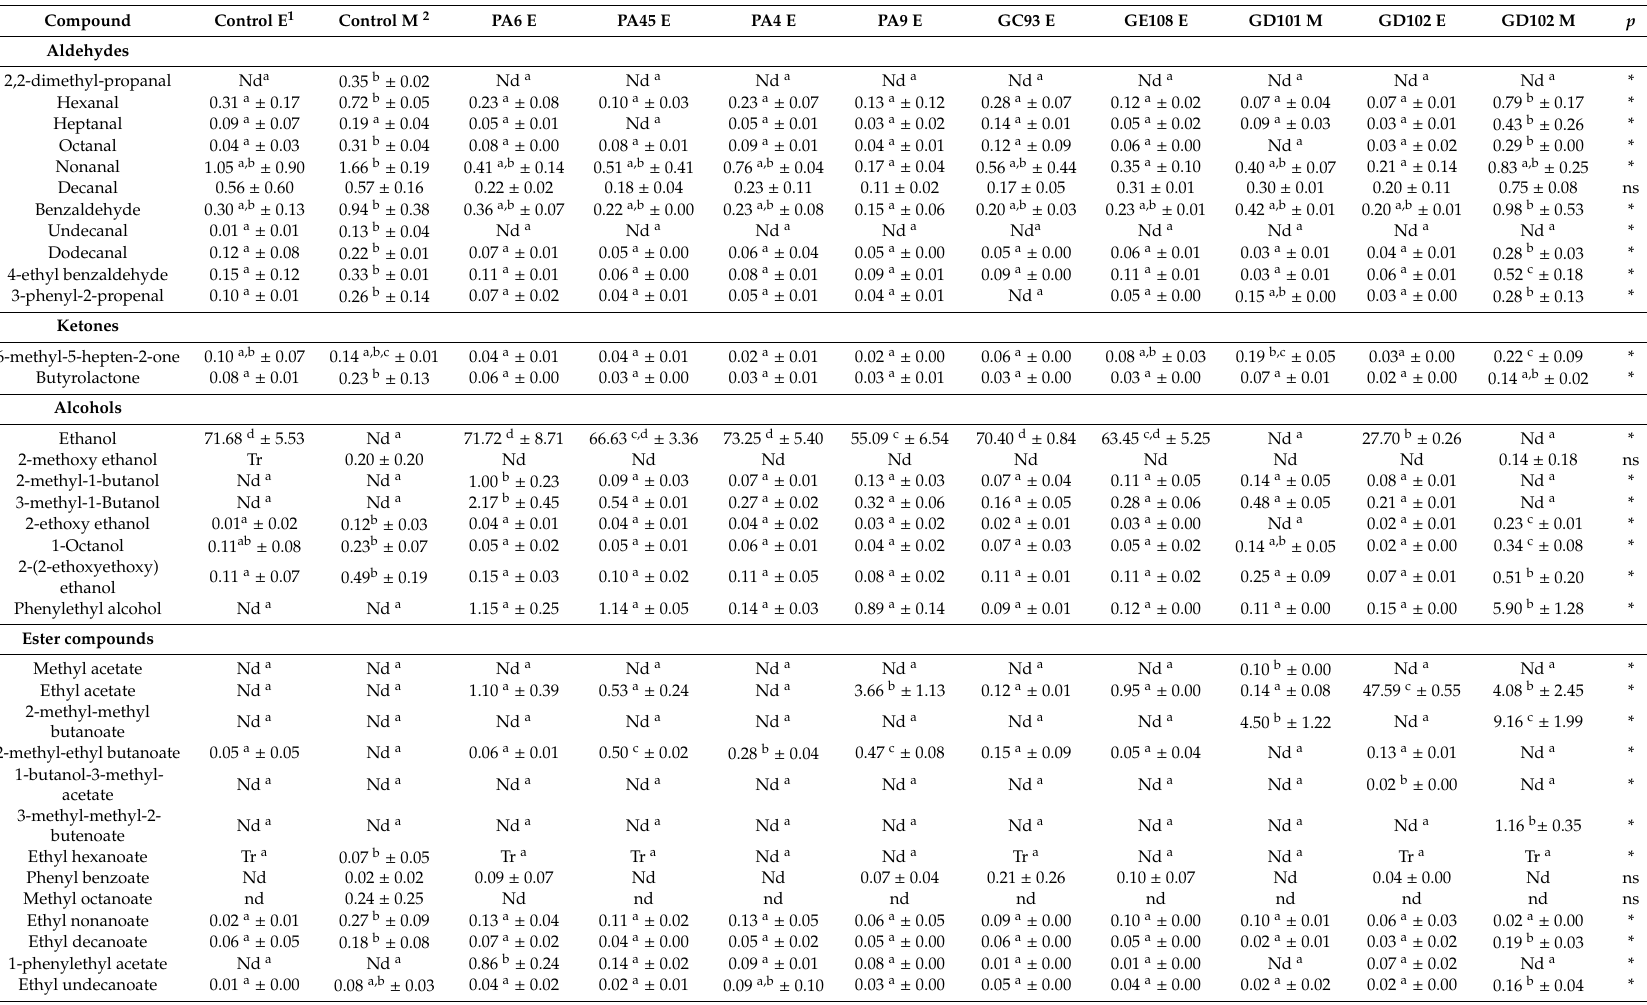
Table 5. Volatile compounds quantified (mean ± standard deviation) in the headspace of samples with ethanol or methanol after incubation with di ff erent strains of yeasts (expressed in percentage of the area with respect to the total area quantified multiplied per